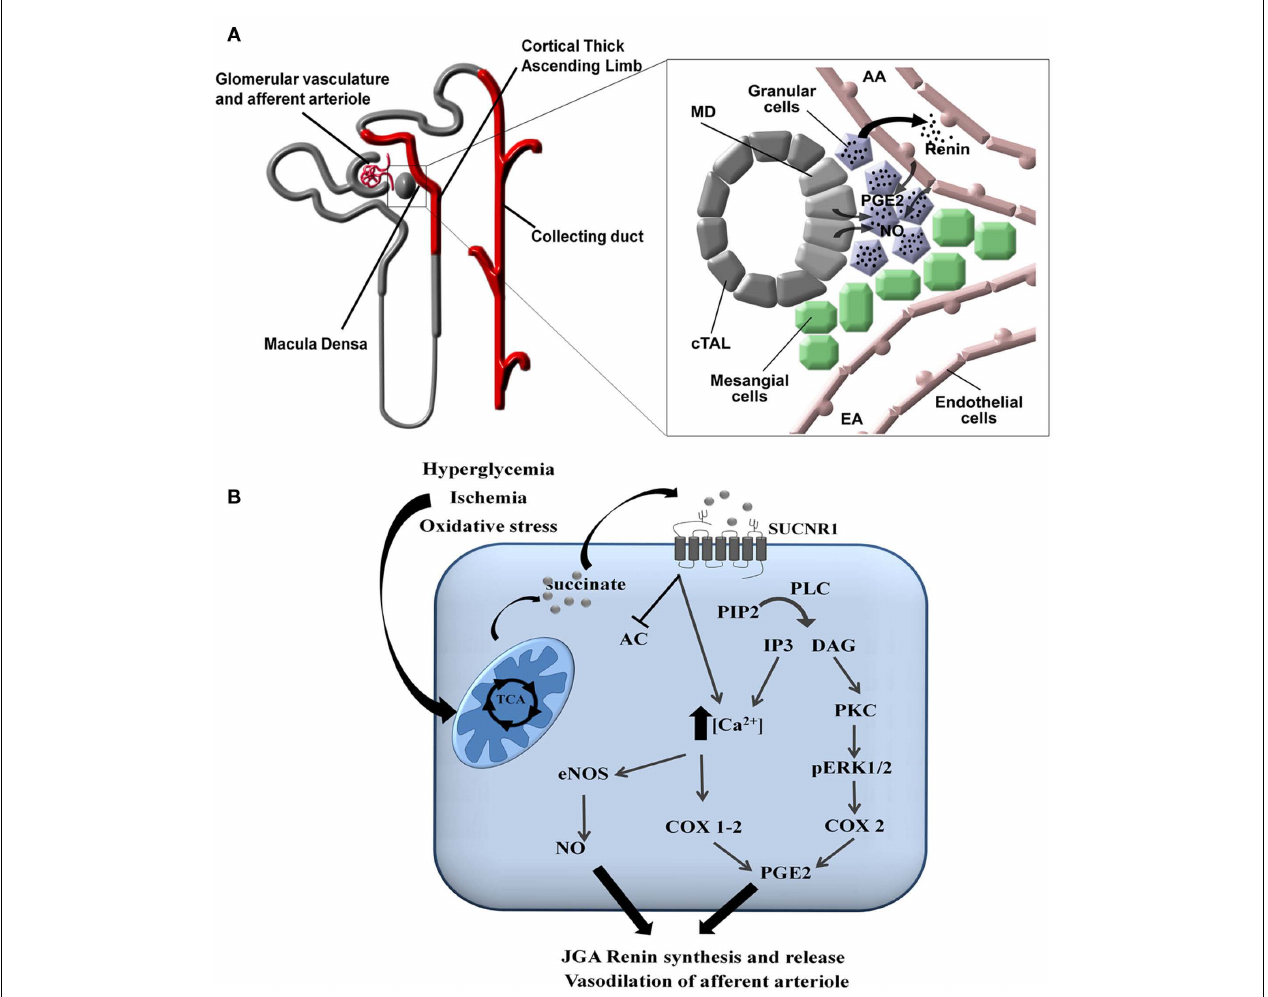
the functioning of the mitochondria, resulting in the release of succinate into the cytoplasm and eventually to the extracellular environment.There, it can bind to SUCNR1 on the cell surface.This triggers a signaling cascade that eventually leads to the secretion of nitric oxide (NO) and prostaglandin E2 (PGE2).These signaling molecules will subsequently promote the release of renin from the JGA as described under (A) . Abbreviations: PIP2, Phosphatidylinositol 4,5-bisphosphate; PLC, phospholipase C; DAG, diacylglycerol; IP3, inositol 1,4,5-trisphosphate; PKC, protein kinase C; pERK1/2, phosphorylated extracellularly regulated kinase 1/2; COX, cyclo-oxogenase, eNOS, endothelial nitric oxide